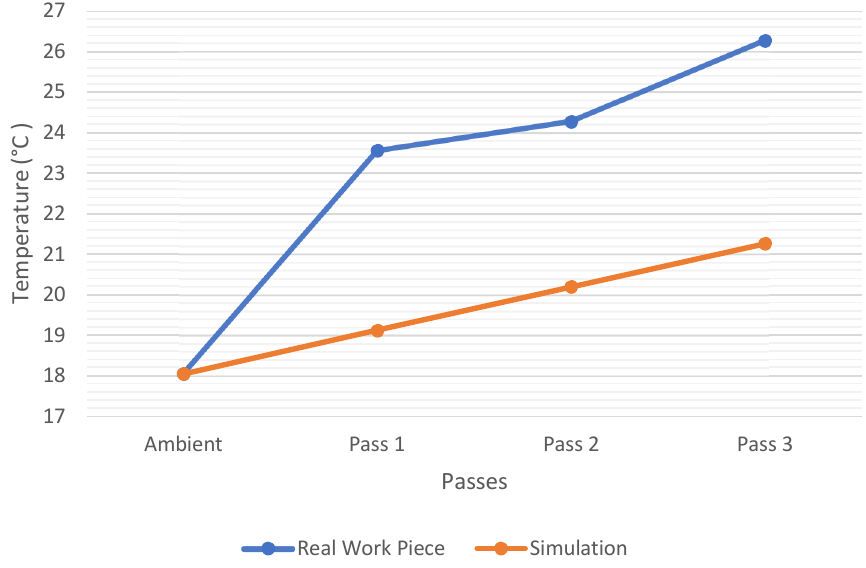
Figure 6. Comparison of real-world experimentation and FEA simulation data.